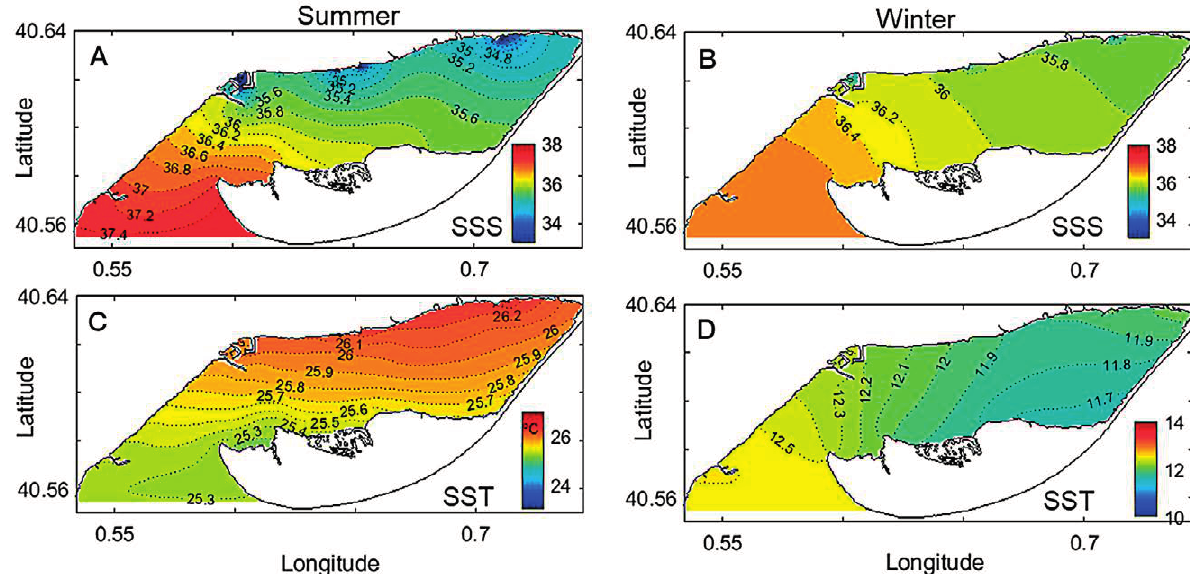
Fig 8. – Left: images for summer simulations (July-September 2013). Right: images for winter simulations. The top images represent the averaged salinity at 0.75 m (SSS) below the surface, and the bottom panels show the sea surface temperature